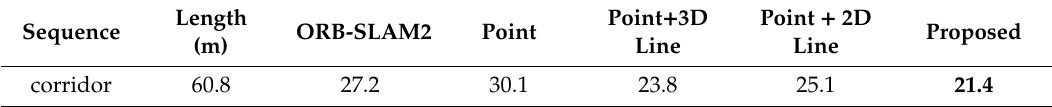
Table 3. Comparison of RMSE (cm) of point-to-point distance on corridor sequence.